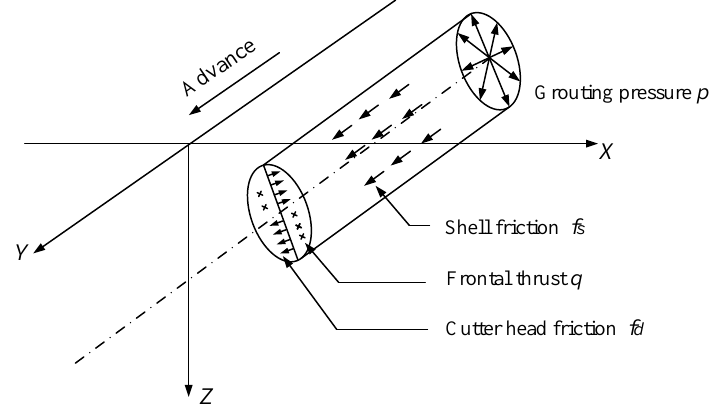
Figure 4. Four mechanical effect factors.